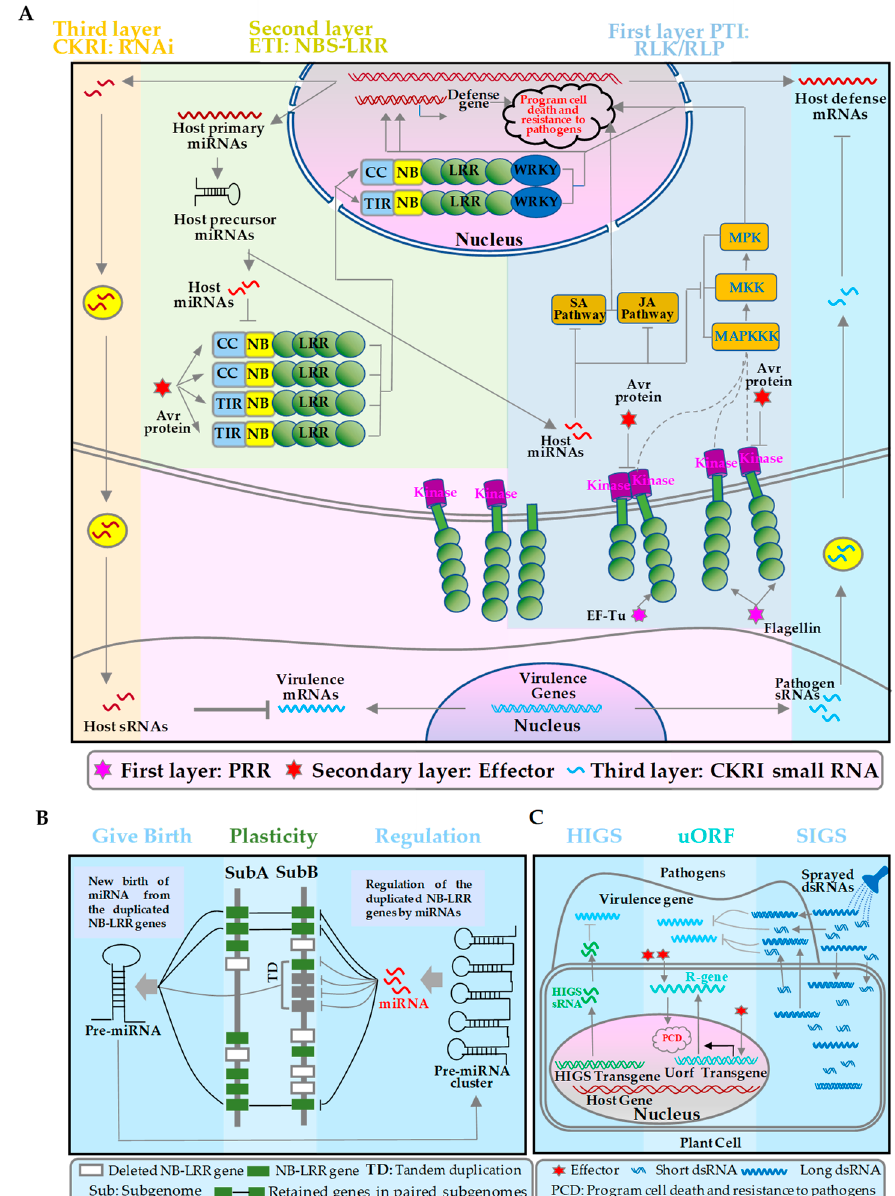
Figure 2. The interaction mechanisms of plants-pathogens from three interacted and miRNA regulation layers. ( A ) The three defensive layers in plants including the PTI, ETI, and cross-kingdom RNA interference (CKRI), and the three infection layers in pathogens including pattern recognition receptors (PRR), effector and CKRI. ( B ) The evolution of NBS-LRR genes and their regulator miRNAs. ( C ) The three strategies of defense to biotic stresses including uORF [83], host-induced gene silencing (HIGS) [84–92] and spray-induced gene silencing (SIGS) [3,93–96] in plants.